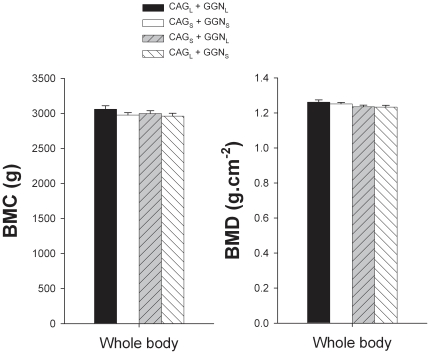
Whole body bone mineral content (BMC) and bone mineral areal density (BMD).Subjects were grouped as CAG short (CAGS) if harboring repeat lengths of ≤21 and CAG long (CAGL) if harboring repeat lengths of >21. The cutoff point for GGN short (GGNS) was GGN repeat polymorphism ≤23, otherwise subjects were included in the GGN long (GGNL) group. Four haplotypes combinations were defined as: CAGL + GGNL, CAGS + GGNS, CAGS + GGNL, and CAGL + GGNS.